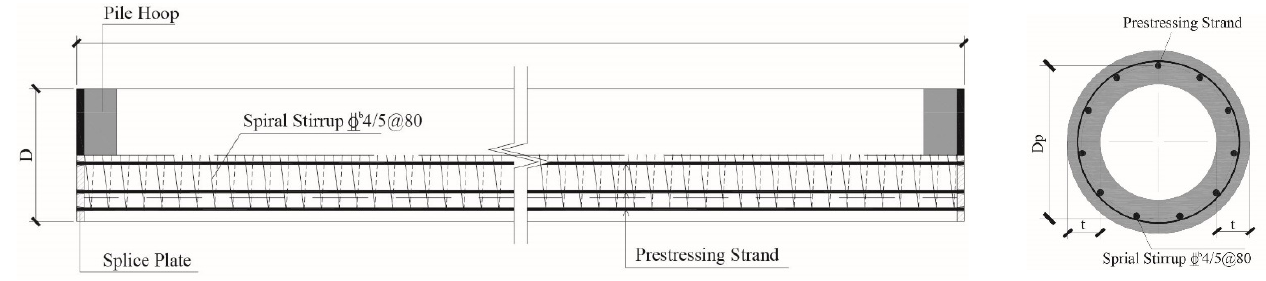
Figure 5. Schematic diagram of reinforcements in pile test specimens: (unit: mm). Table 3. Detailed dimensions of specimen.